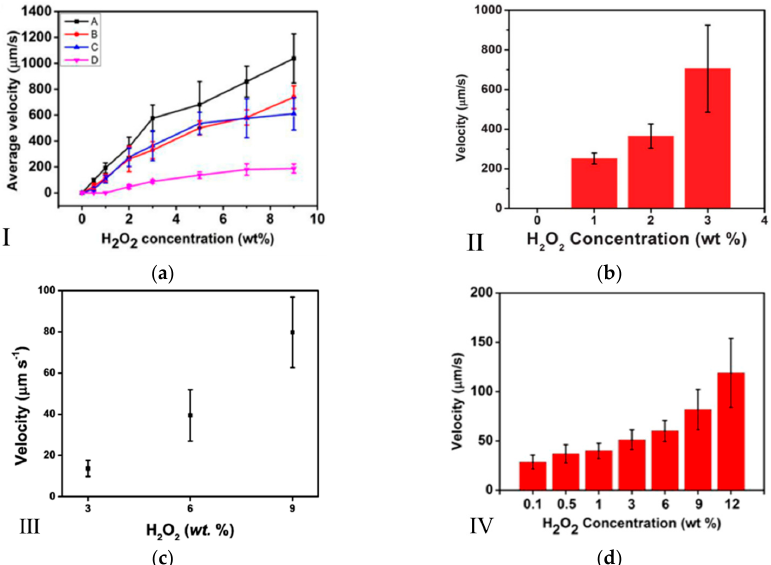
Figure 2. The relationship between the concentration of H 2 O 2 and micromotors of different shapes. ( a ) The dependence of the average velocity of the four type of tubular micromotors on the concentration of H 2 O 2 [59]. (A. Electrodeposited in 5 μ m pores; B. Electrodeposited in 2 μ m pores; C. Electrodeposited in 2 μ m pores (shorter deposition time); D. Electrodeposited in 200 nm pores.) ( b ) The relationship between the average velocities of microjets and the concentration of fuel [53]. ( c ) The dependence of the velocity of Janus Ag micromotors on the hydrogen peroxide concentration [60]. ( d ) The relationship between the average velocity of Ag catalytic micromotors on H 2 O 2 concentration at 23 °C [61]. Reproduced with permission from [53,59–61].